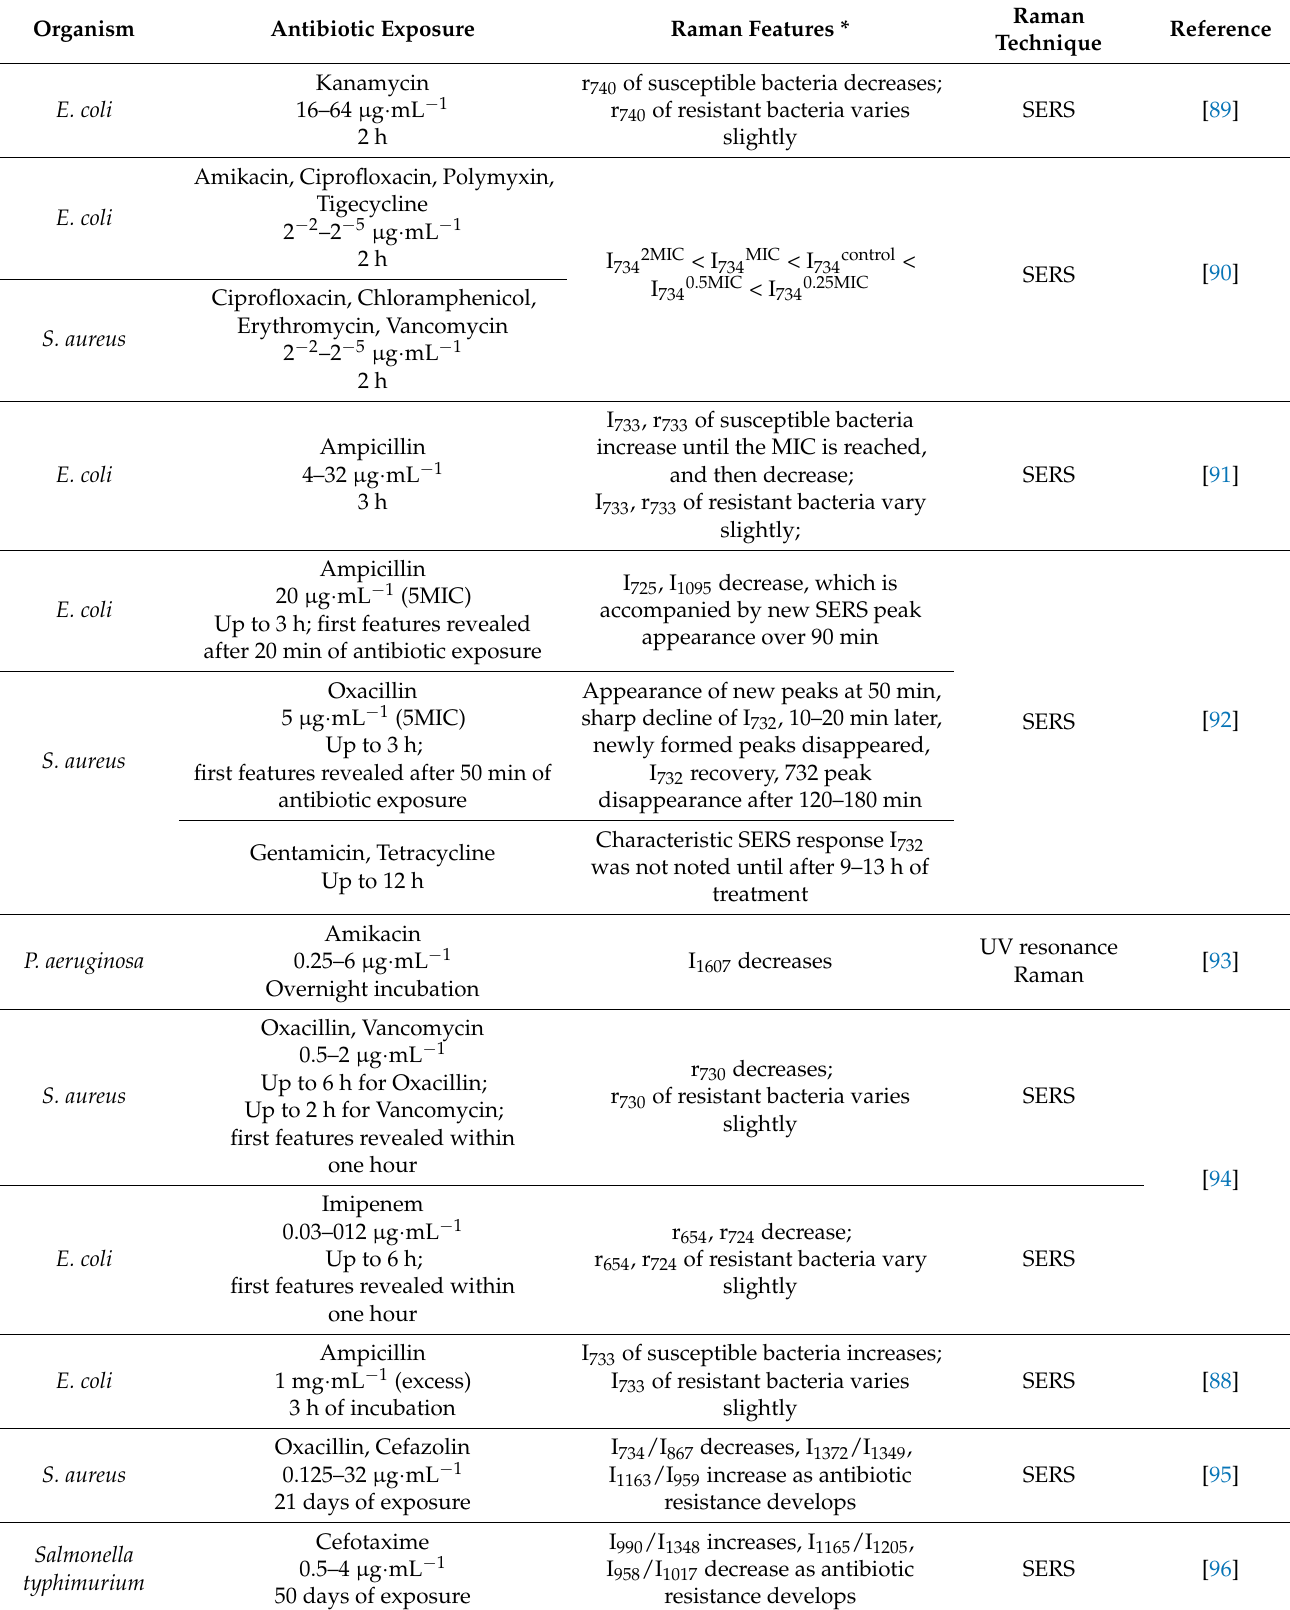
Table 1. Raman features observed in the antibiotic-treated